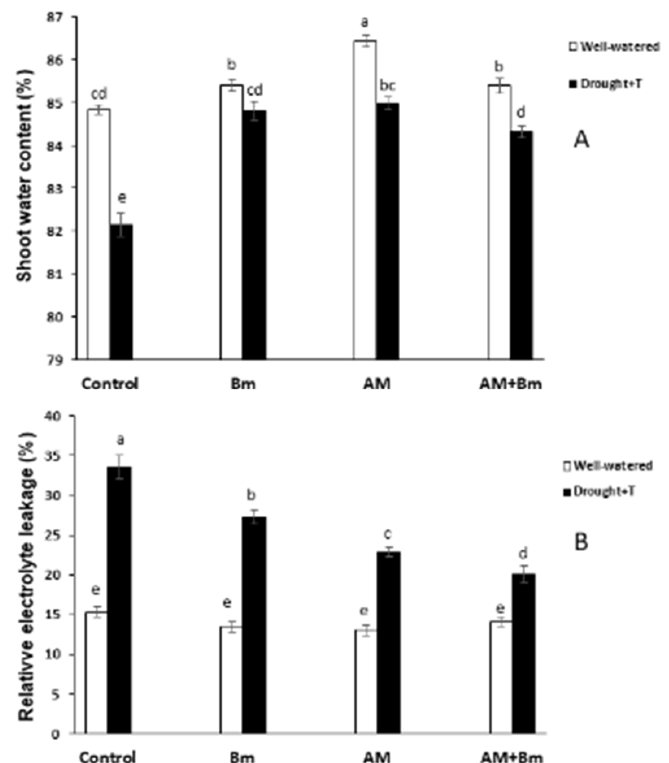
Figure 2. ( A ) Shoot water content and ( B ) relative electrolyte leakage in maize plants inoculated or not (control) with a PGPR strain of Bacillus megaterium (Bm), with the arbuscular mycorrhizal fungus Rhizophagus irregularis (AM) or with both microorganisms (AM + Bm). Plants were cultivated under standard ambient temperature and well ‐ watering conditions (well ‐ watered) or subjected to a combined drought and high temperature stress (drought + T) for 15 days before harvest. Data represent the means (n = 15) (shoot water content) or (n = 6) (relative electrolyte leakage) ± S.E. Different letters indicate significant differences between treatments ( p < 0.05) based on Duncan’s test.